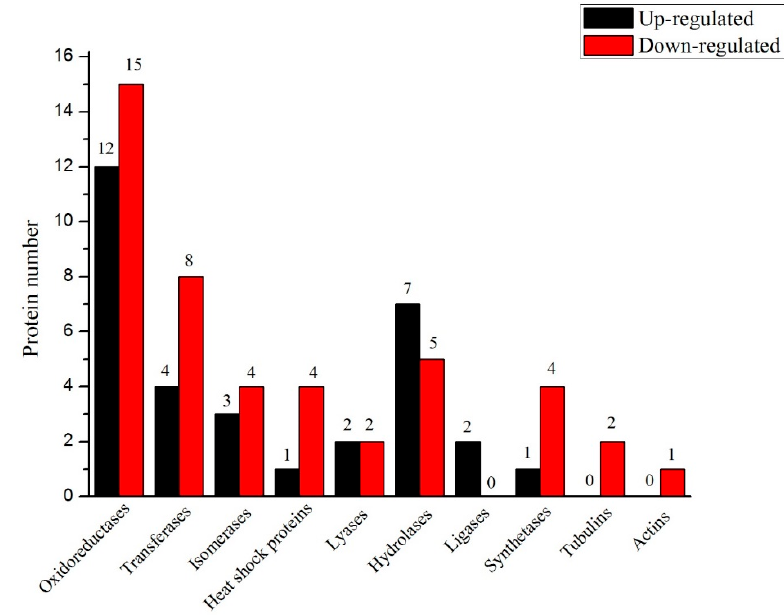
Figure 7. The ten categories of significantly differentially expressed proteins in S727 and S3057.